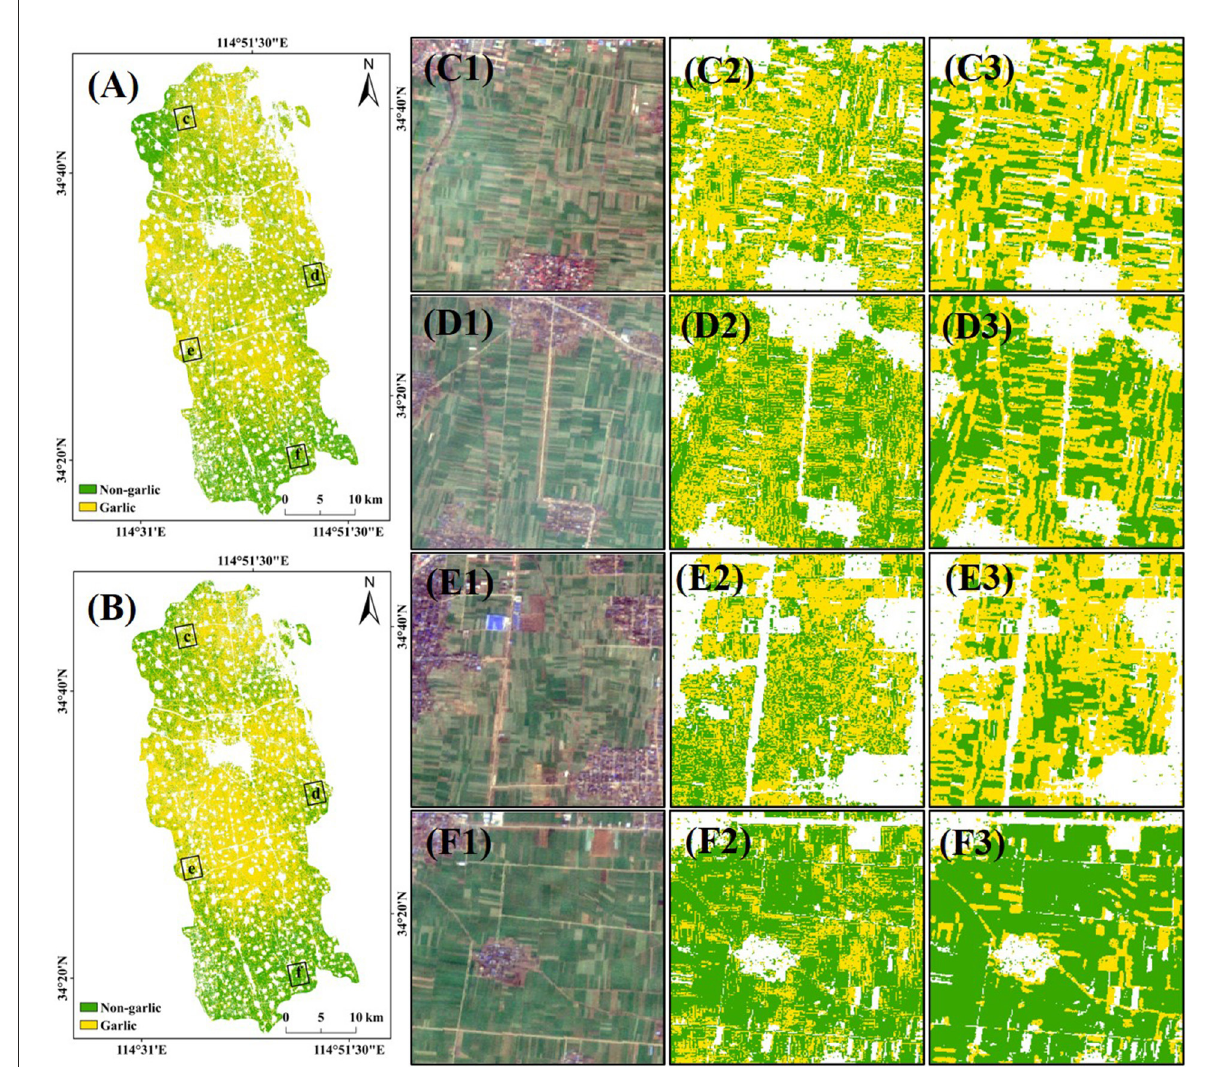
FIGURE14 (A) Distribution of garlic in Qi County in 2020 only based on S2. (B) Distribution of garlic in Qi County in 2020 based on S2 and S1. Four regions, denoted as c, d, e, and f in (A,B) , were selected randomly. The 10-m resolution views from Sentinel-2 (December 19, 2019) are shown in (C1,D1,E1,F1) , and the zoom-in views in (A,B) for the four regions are shown in (C2,D2,E2,F2,C3,D3,E3,F3) .